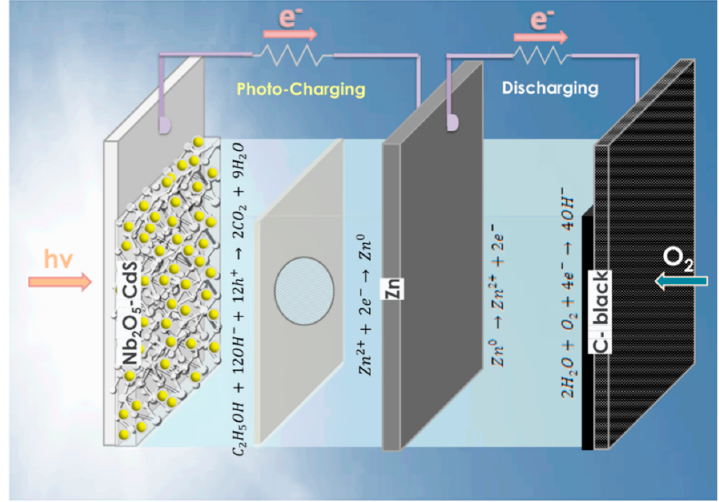
Figure 1. Illustration of the reactor where a Nb 2 O 5 -CdS photoelectrode is used to photo-charge a typical Zn-air battery through C 2 H 5 OH oxidation.